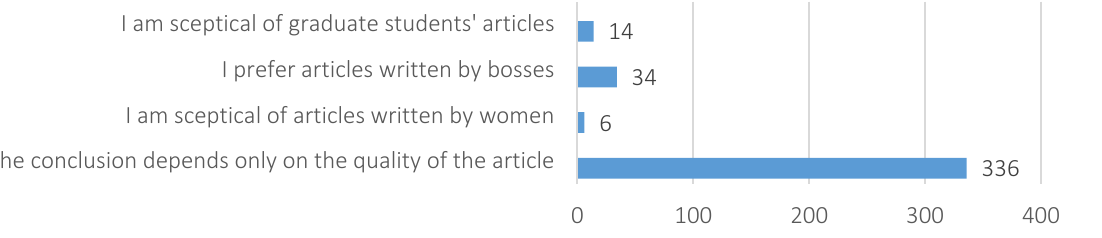
Figure 6. Distribution of answers to the question “How impartial are your